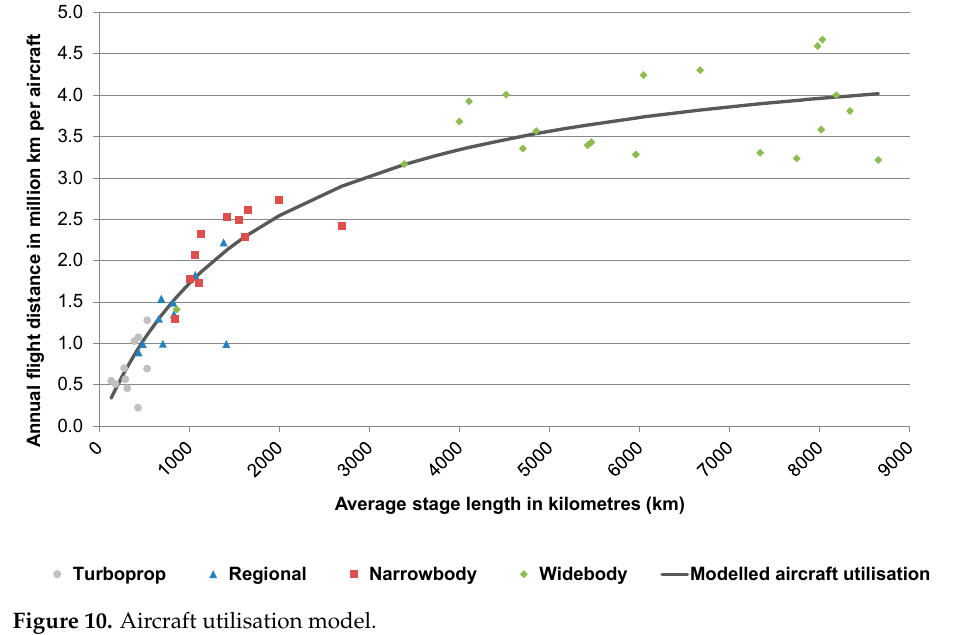
Figure 10. Aircraft utilisation model. Table 2. Aircraft utilisation model accuracy (data from